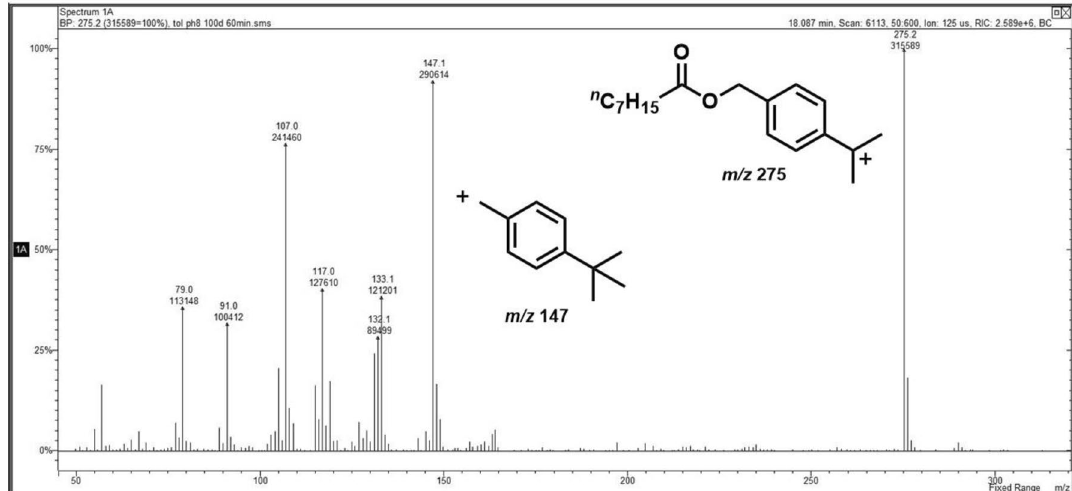
Fig. 4 The EI mass spectrum of 4- t -butylbenzyl octanoate (MW 290)